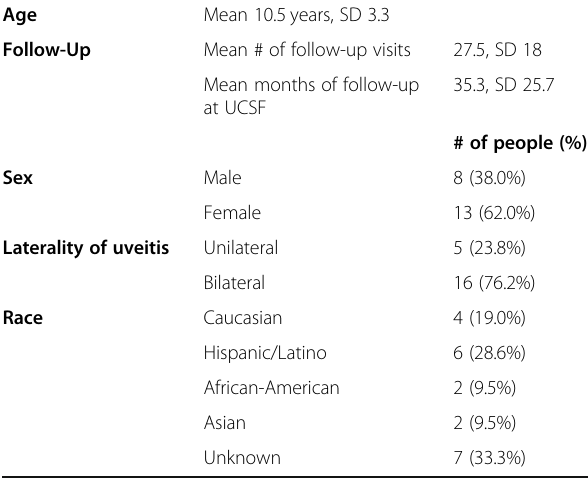
Table 1 Demographic Characteristics of Patients with Non-